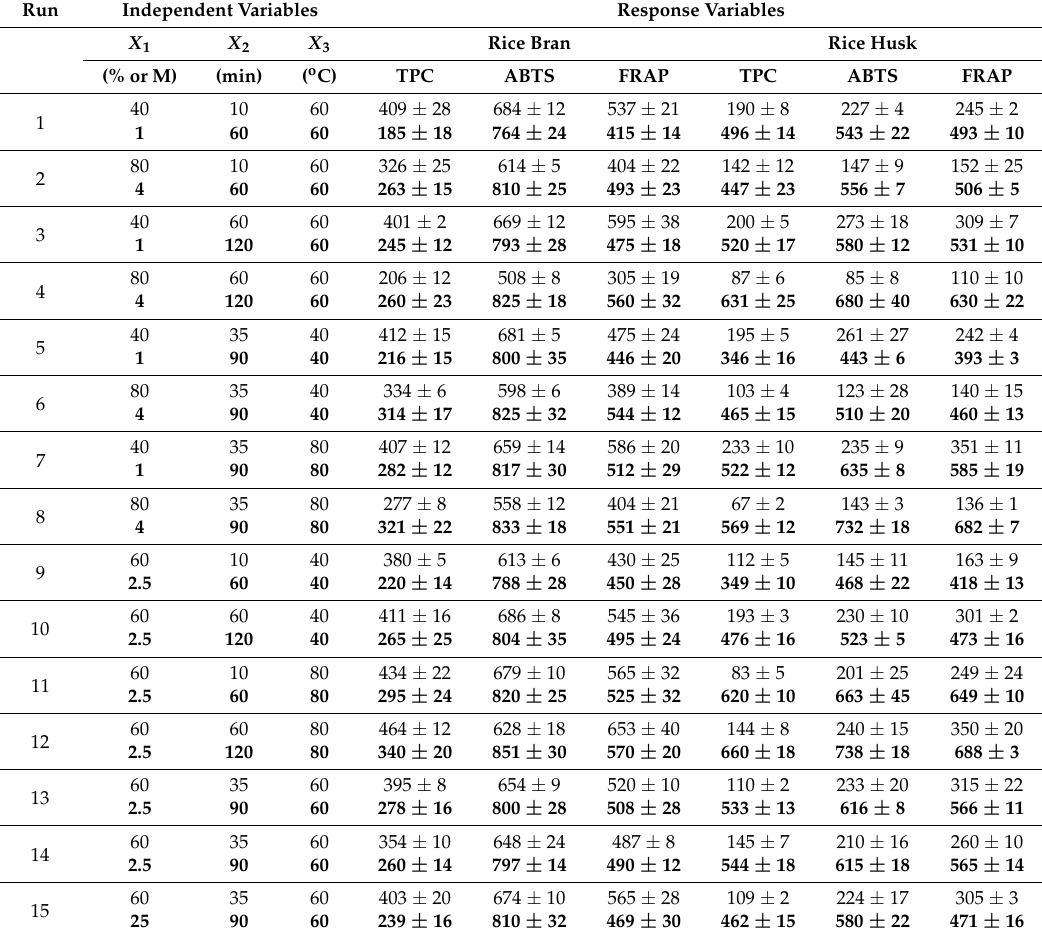
Table 1. Box-Behnken design for the independent variables and response values for free and bound